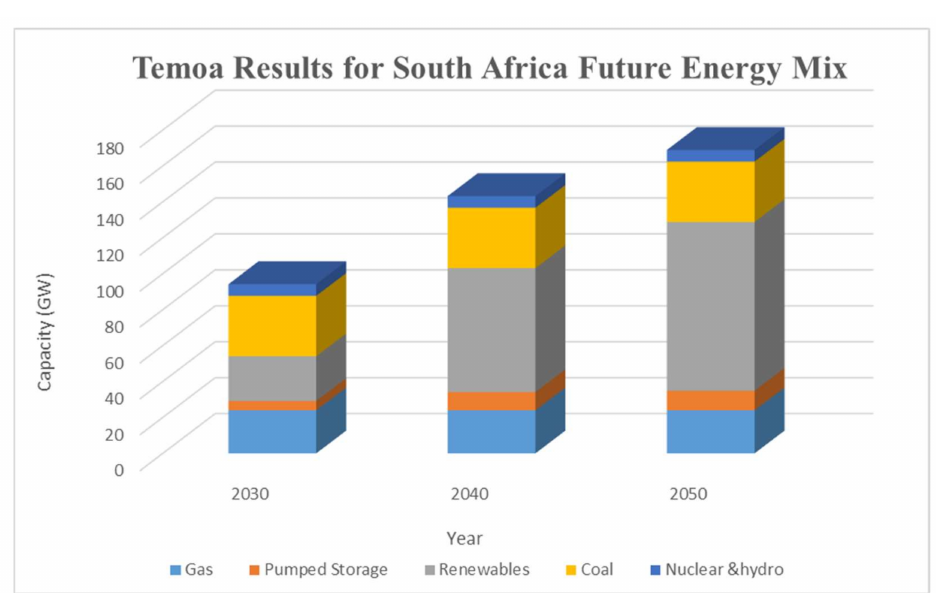
Figure 6. Temoa Results for South Africa Future Energy Mix using the same inputs as the IRP 2019 for PS.